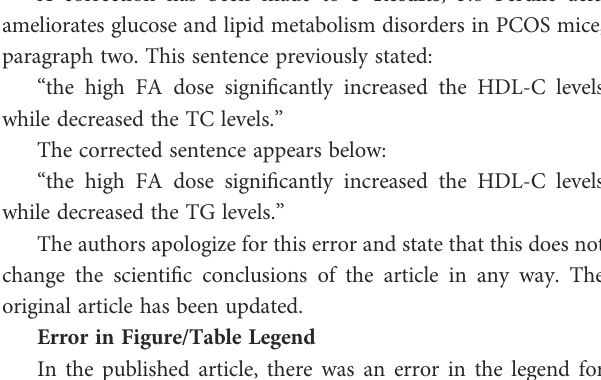
Figure 2 legend, “ FA instead of FC days. ” The correct material